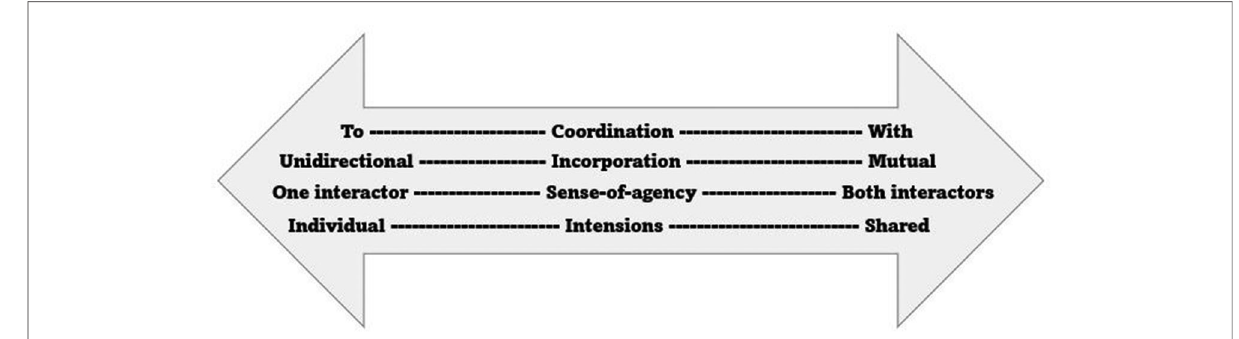
FIGURE 1 The continuums of the enactive terms coordination, incorporation, sense-of-agency, and